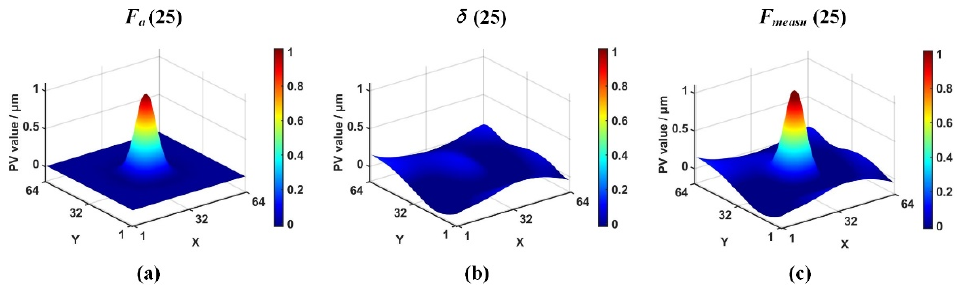
Figure 2. Comparison between 𝐹 (cid:3040)(cid:3032)(cid:3028)(cid:3046)(cid:3048) and 𝐹 (cid:3028) , taking the 25th actuator as example. ( a ) 𝐹 (cid:3028) (25) , ( b ) 𝛿(25) that is added to the 𝐹 (cid:3028) (25) , ( c ) 𝐹 (cid:3040)(cid:3032)(cid:3028)(cid:3046)(cid:3048) (25)